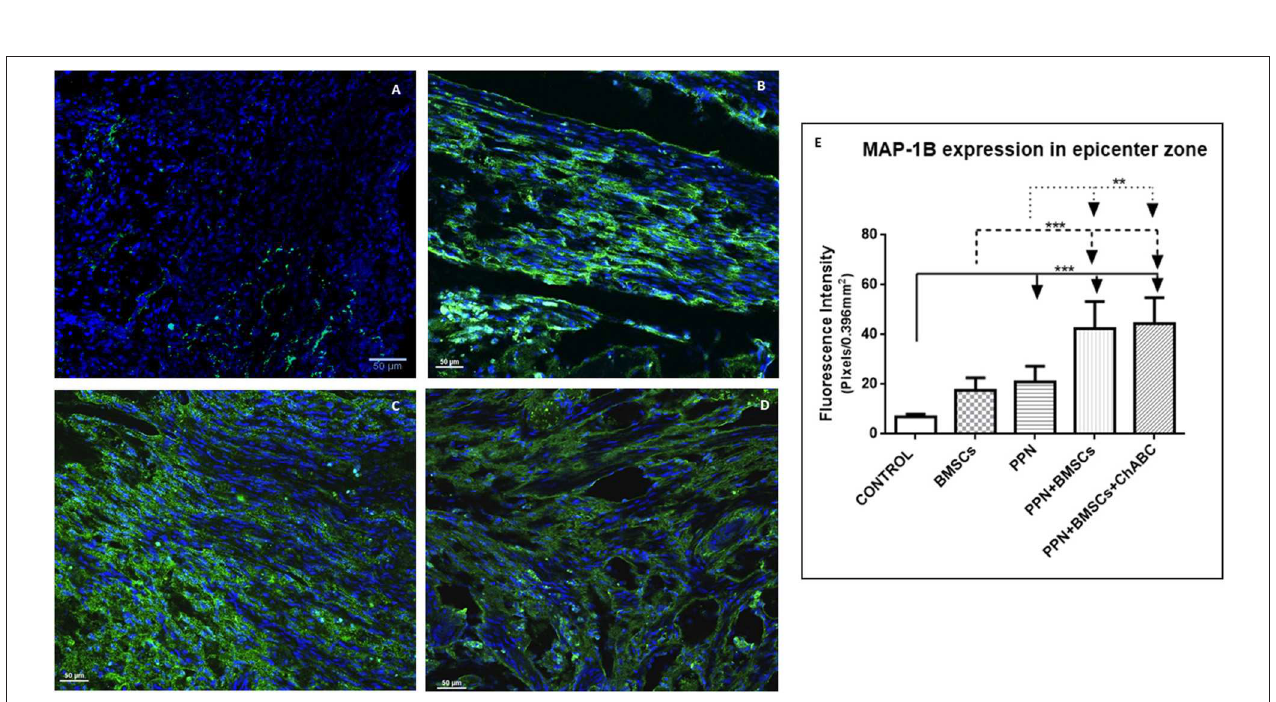
FIGURE 3 | Expression of MAP-1B at the epicenter. (A–D) Show representative images of immunoreactive fibers for MAP-1B (green) of groups control (A) , PPN (B) , PPN + BMSCs (C) , and PPN + BMSCs + ChABC (D) . Note that fibers in the PPN group seem disordered, scarcer, and thinner compared to combined groups. Scale bar (A–C) = 50 µ m. Plots in (E) show quantification of fluorescein density at the epicenter zone. Data are expressed as the mean ± S.D. ( n = 6). Statistical analysis: Kruskal Wallis followed by U -Mann Witney. *** p < 0.0001; ** p < 0.05.